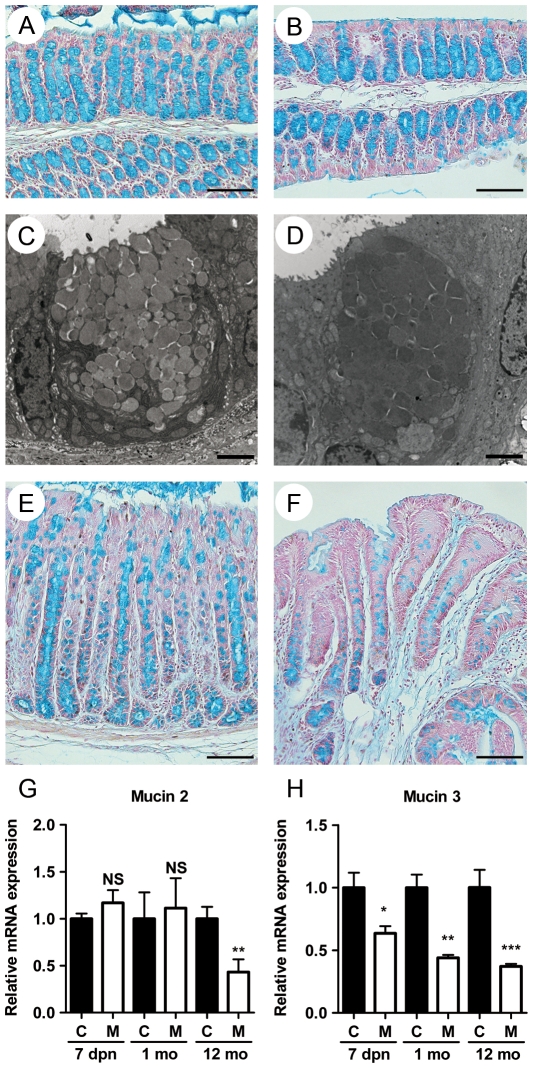
Loss of Hnf4α does not compromise goblet cell maturation in healthy colon mucosa but in long term inflamed colon mucosa.(A) Alcian blue staining of control mice aged of 12 months. (B) Healthy colon region of 12 month-old mutant mice showing normal size and number of goblet cells (Scale bar, 100 µm). Electron microscopy shows a similar maturation level of goblet cells in control (C) and mutant mice (D) (Scale bar, 2 µm). (E) Small size goblet cells in hyperplasic epithelium of 12 month-old mutant mice. (F) Drastic reduction in goblet cell number in hyperplasic crypts (Scale bar, 100 µm). (G) qRT-PCR of Muc2 mRNA and (H) Muc3 mRNA in Hnf4α mutants (Open bars) and controls (Black bars). Expression levels are shown as mean values (± SEM) relative to controls and were normalized with the Hprt gene. **P≤0.01 and ***P≤0.001.